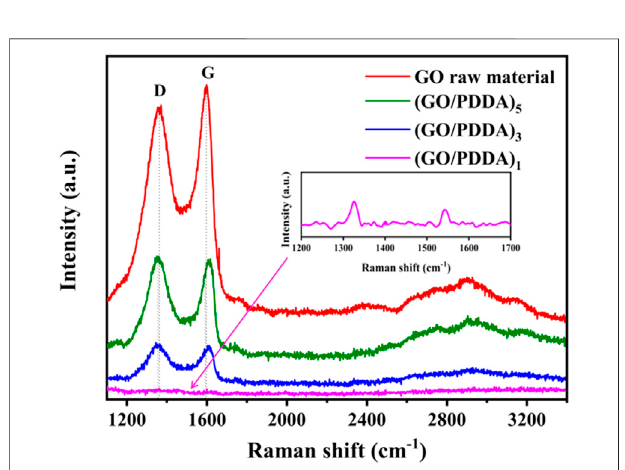
FIGURE 5 | Raman spectra of GO material and (GO-PDDA) n fi